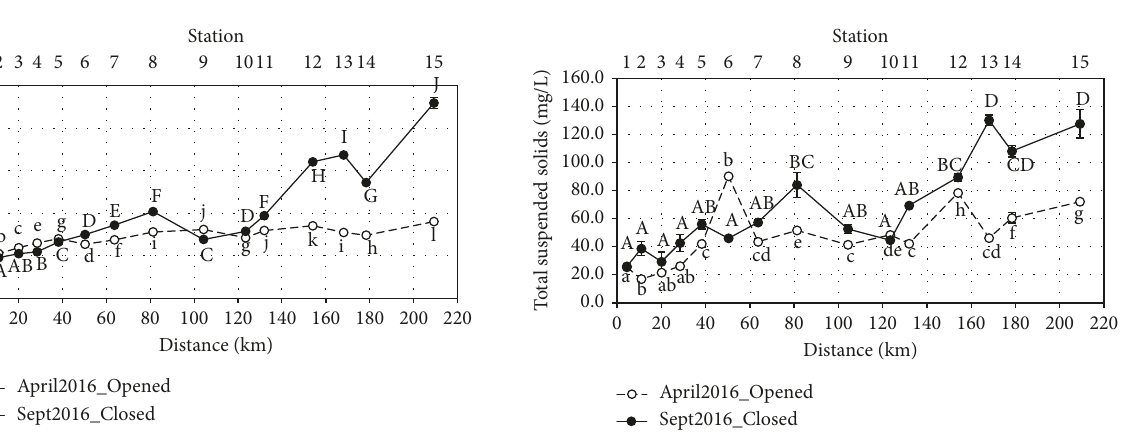
Figure 7: Total suspended solids at the 15 stations downstream of Bakun Hydroelectric Dam during opened spillway ( o ) and closed spillway ( • ). The same letter indicates no significant difference ( p > 0 . 05).